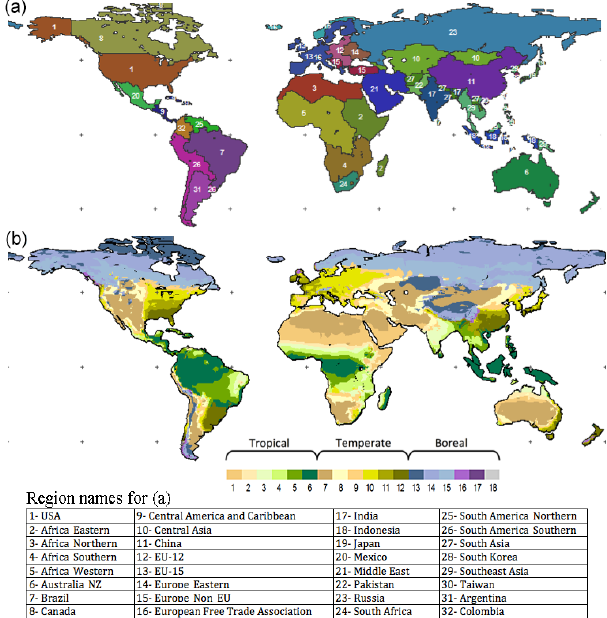
Figure 1. (a) 32 GCAM regions. (b) Agroecological zones (AEZs).